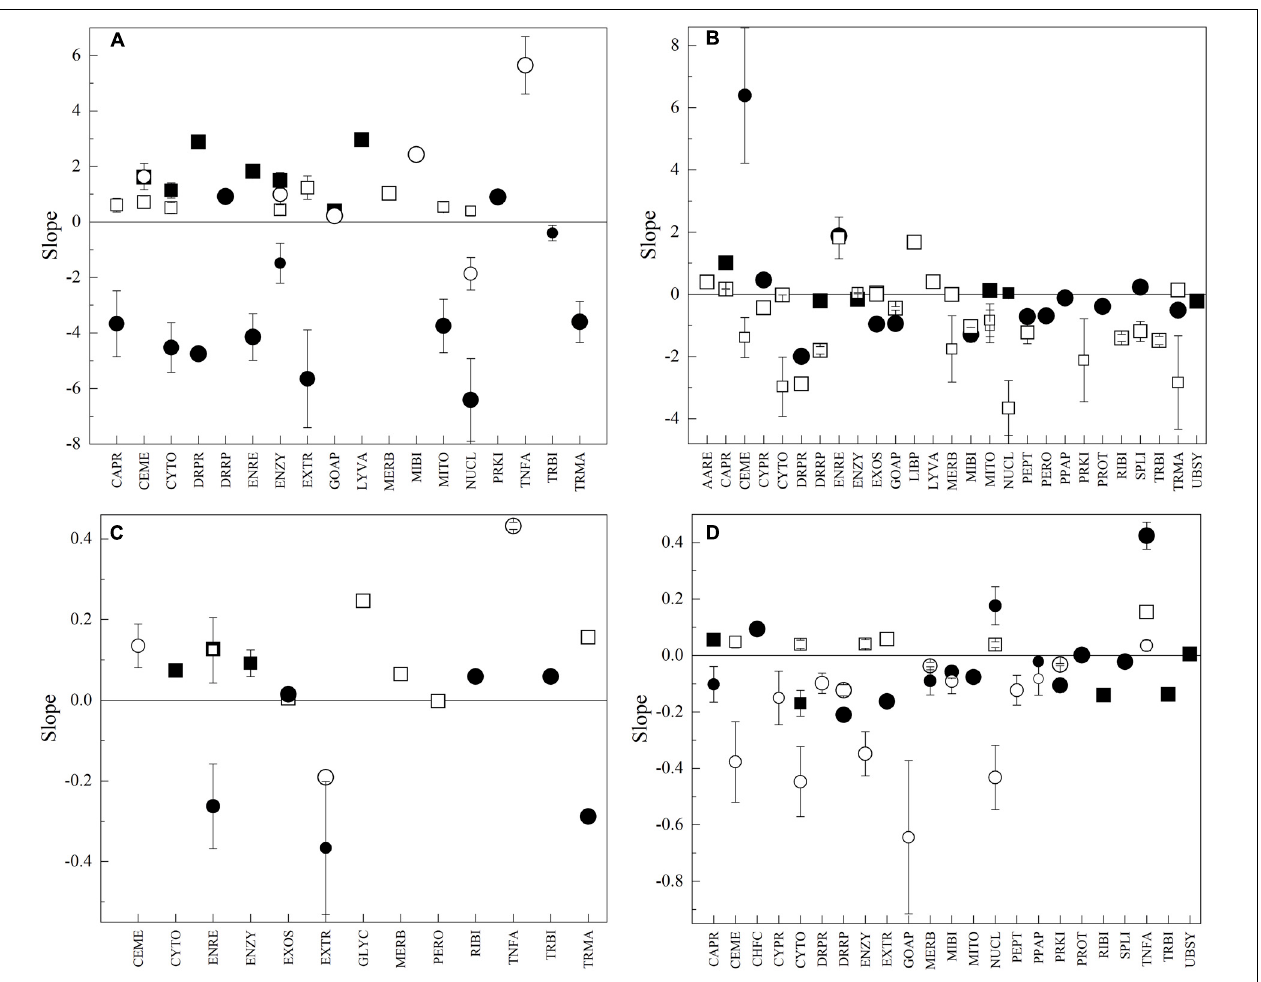
FIGURE 6 | Correlation between amino acid parameters of CDS groups and optimal temperature for growth and growth rate of yeasts. In plots, the results for regression of at least R 2 ≥ 0.7 are shown. In relation to optimal temperature for growth in yeasts having growth rates lower (A) and higher (B) than 1 h − 1 and in relation to growth in yeast having optimal temperatures for growth from 10 to 15 ◦ C (C) and 19 to 22 ◦ C (D) . The size of the symbol represents R 2 from 0.7 to 1.0.